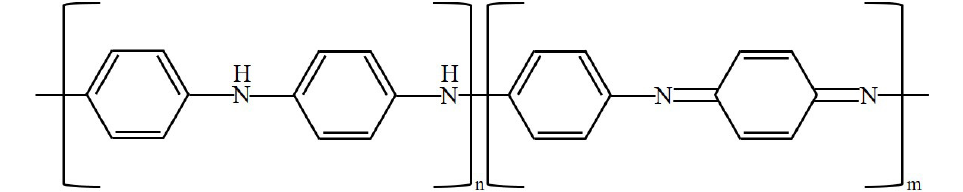
Figure 2. Oxidation of